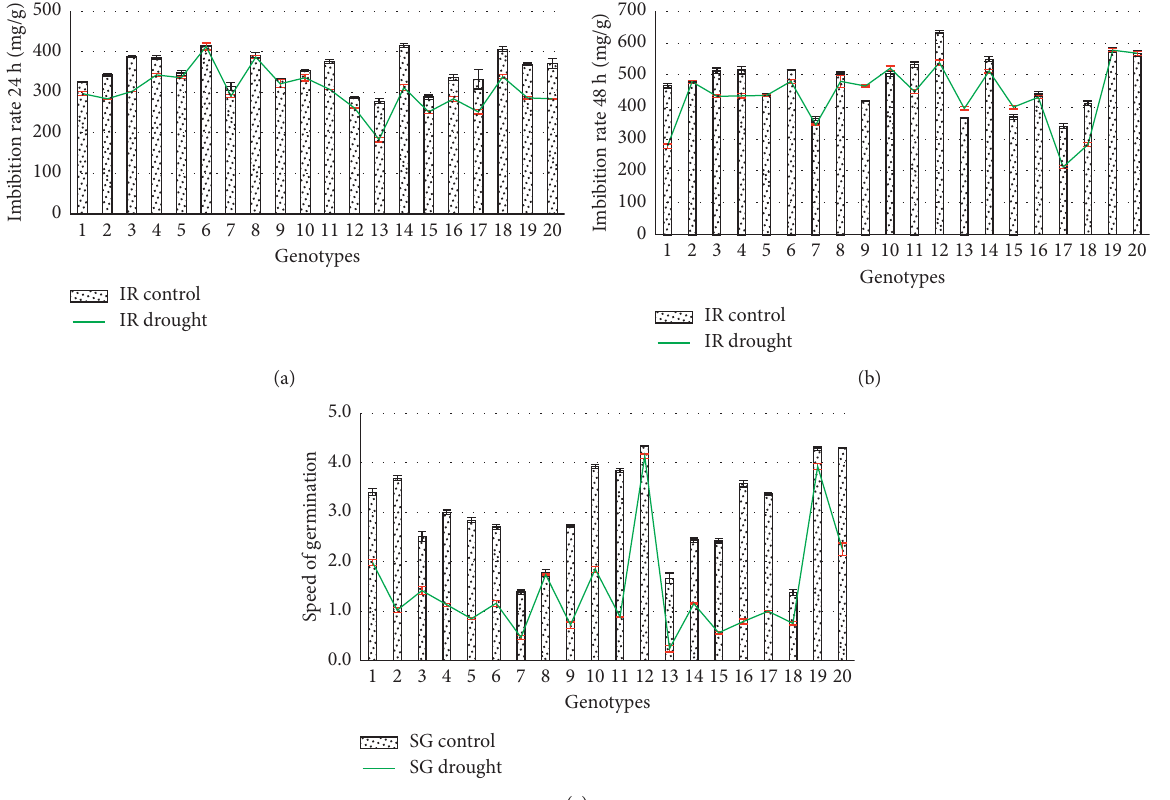
Figure 1: Genotypic response at the germination stage. (a) Imbibition rate (IR mg/g) after 24 hours of sowing. (b) IR (mg/g) after 48 hours of sowing. (c) The speed of germination (SG) after four days of sowing. At the horizontal axis, 1–20 numbers show the genotypes. 1–10 are drought tolerant, 11–15 are moderately drought tolerant, and 16–20 are drought